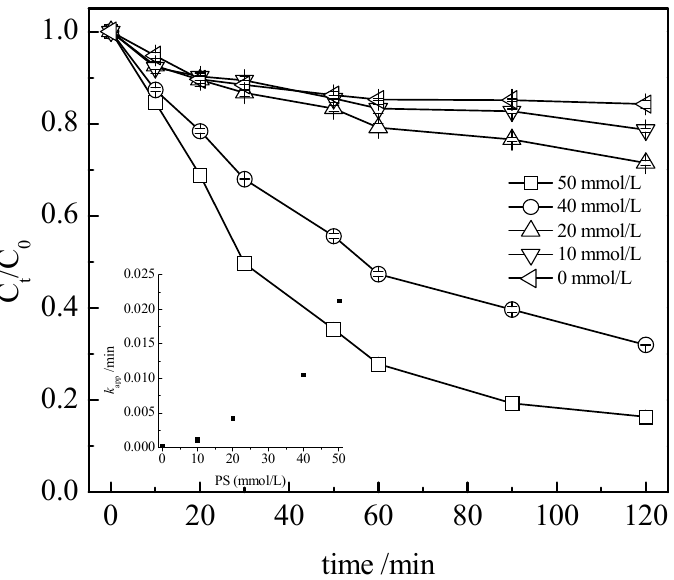
Figure 7. Effect of the sodium persulfate concentration on the tetracycline degradation. Conditions: C 0 = 100 mg L − 1 , [BA] = 0.5 g L − 1 , and pH 0 = 3.7.